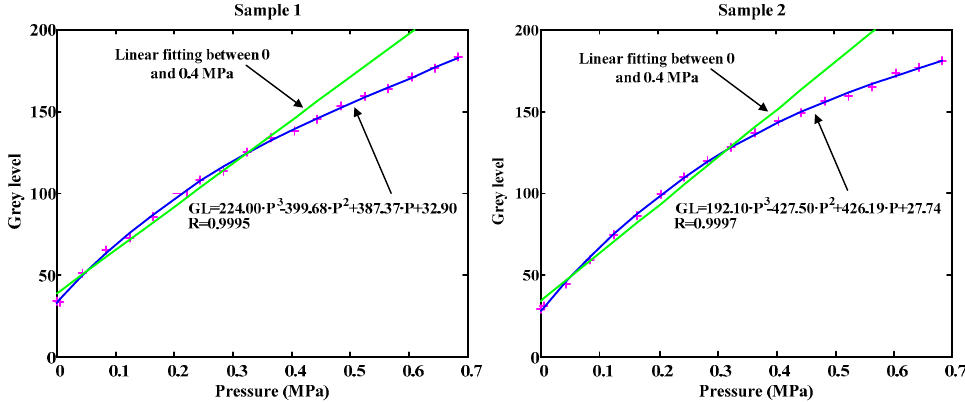
Figure 4. Plastic laminas mechanical saturation.